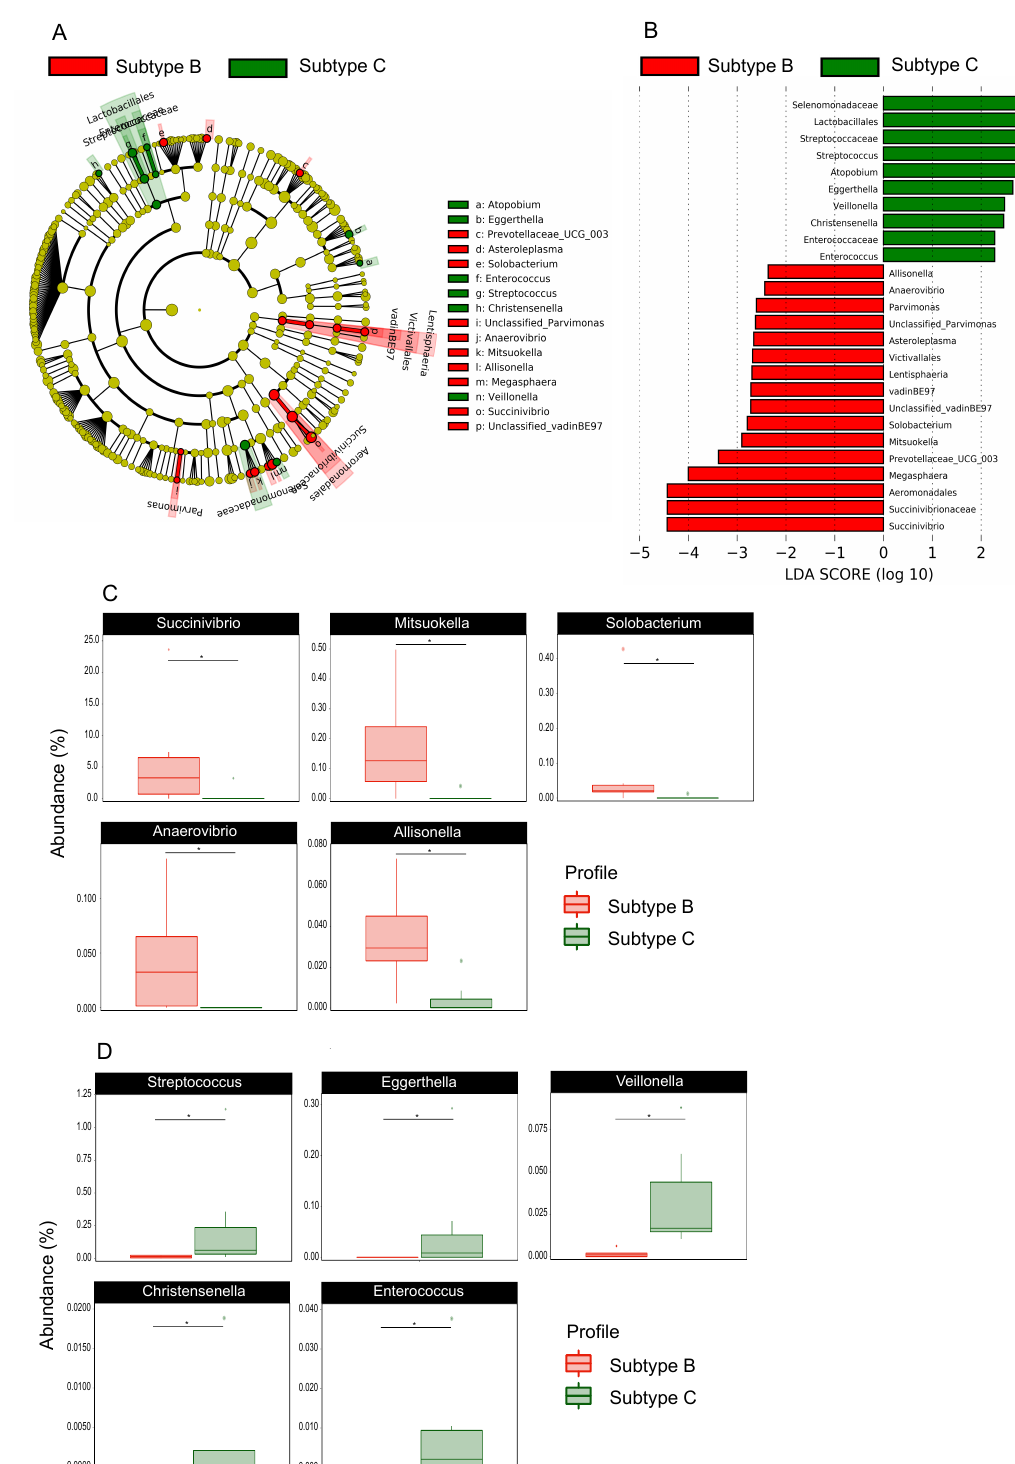
Figure 4. Effects on the gut microbiota according to HIV subtype B and C. LEfSe results for the bacterial taxa that were significantly different between HIV-B and HIV-C infected patients. The cladogram shows differentially abundant taxonomic clades ( A ) and LDA scores showing significant differences between groups ( B ). The relative abundance of genus identified by LEfSe as being differentially more abundant in HIV positive patients infected by HIV subtype B ( C ) and subtype C ( D ) were compared using a Mann–Whitney test. * p values